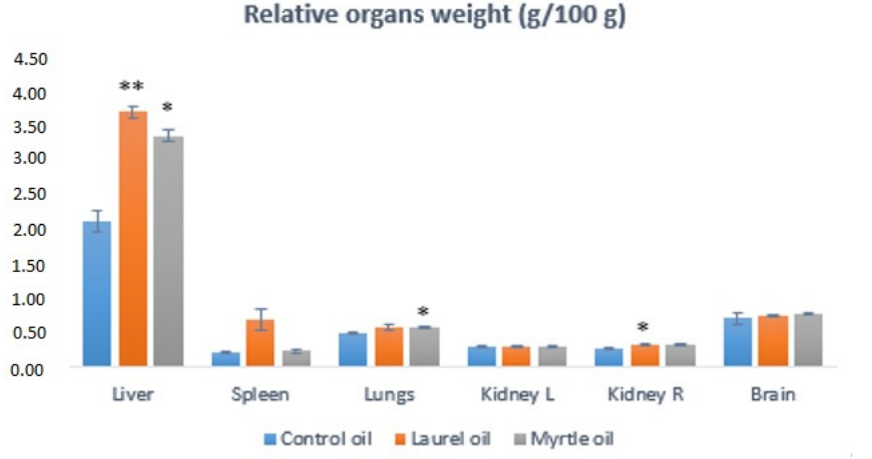
Figure 6. Effect of the laurel and myrtle EO application on relative organ weight. Female rats ( n = 5) were administered ig with laurel and myrtle EOs at a dose of 1 μ L per 1 g of rats once daily for 14 days. Laurel and myrtle EOs were mixed with sunflower oil (1:1) and the total daily volume per rat was 0.5 mL. The control group was treated ig with 0.5 mL of sunflower oil. The results are expressed as the mean value of each experimental group ± SEM. * Significantly different in relation to the control group (* p < 0.05; ** p < 0.01).